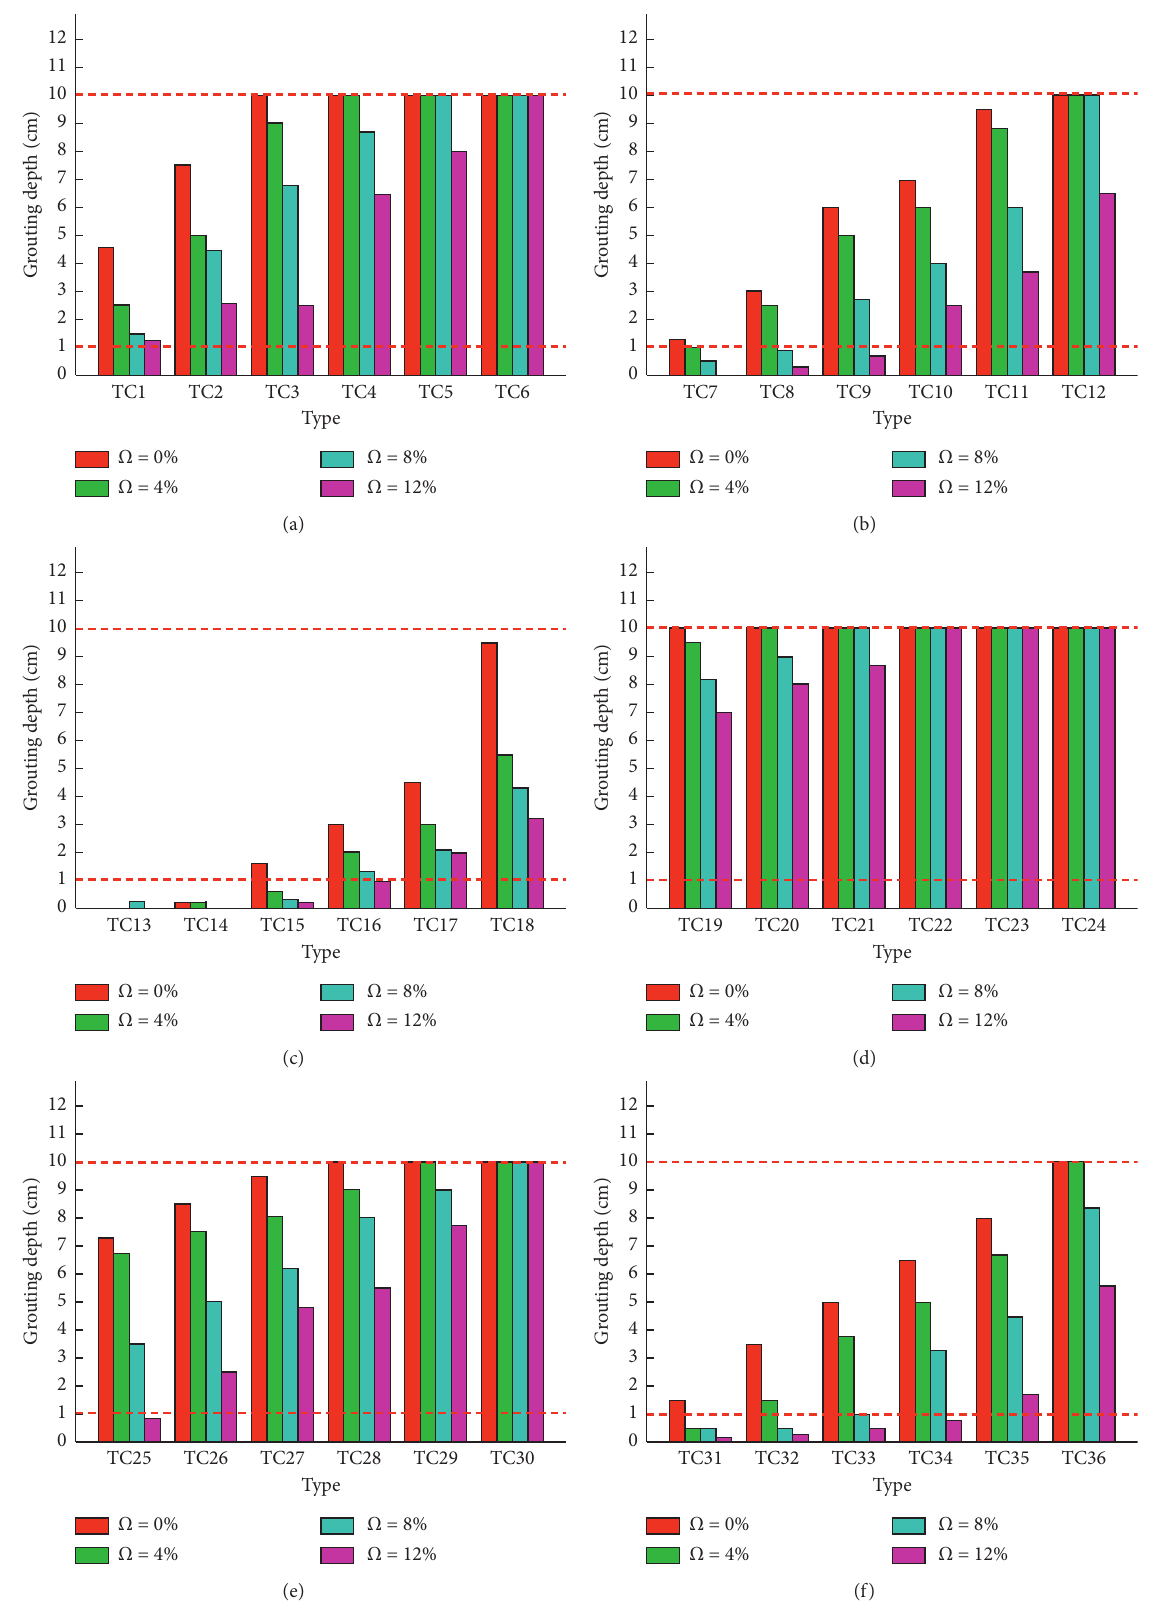
Figure 6: Results of the groutability of the sand layer with varying clay